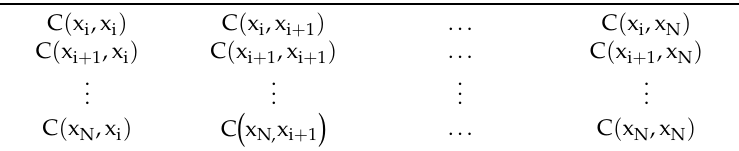
Table 1. Structure of the univariate spatial covariance